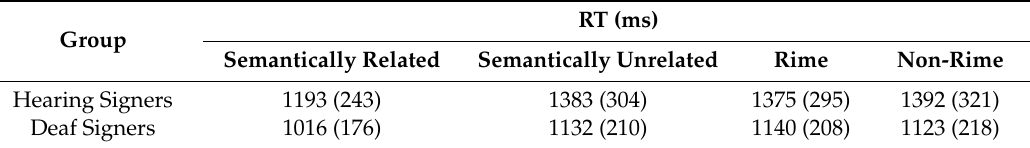
Table 1. Semantic and rime reaction times (mean